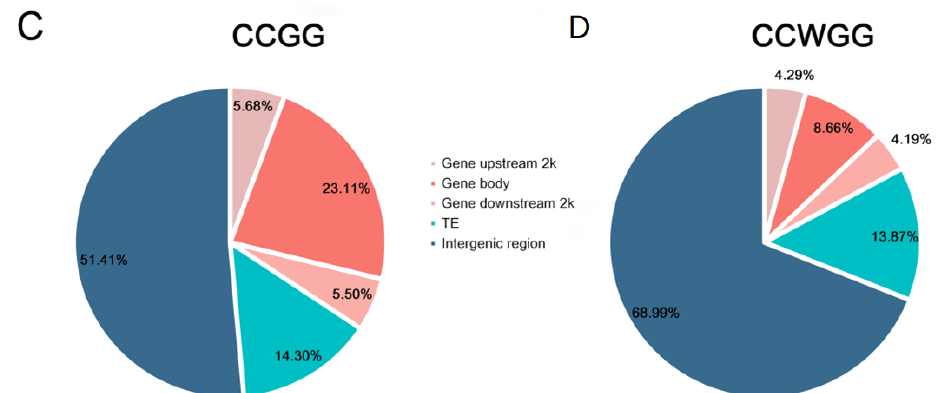
Figure 1. DNA methylation landscapes of hybrids and their parental lines in hybrid contemporary seeds. ( A , B ) Relative average methylation levels in different genomic elements. ( C ) Distribution of methylation sites in soybean genome. ( D ) The significant difference of CCGG and CCWGG methylation levels. The number above black line of two sites is the p value determined by the paired Student’s t -test.